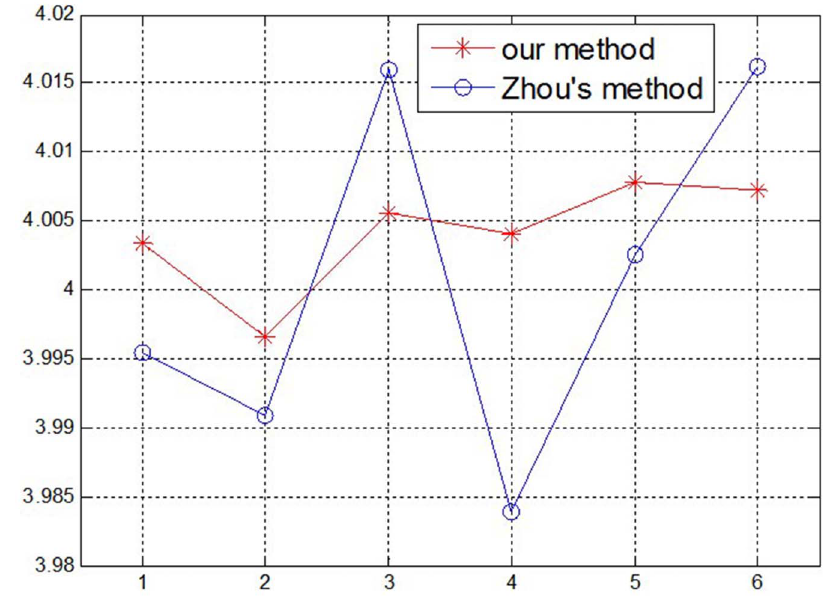
Figure 15. The measurement results of 4 mm Gauge block.